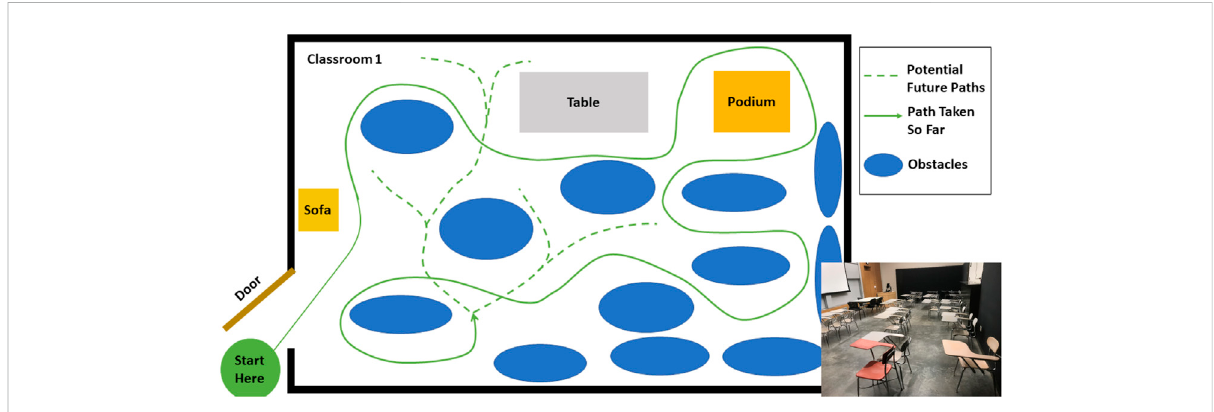
FIGURE 2 Classroom: Architecture of one of the classrooms. The arrangement of obstacles was not controlled and varies across subjects. The subject walked at self-selected speed and along self-selected path, The experimenter directed the subject to change their path only if the subject repeated the same path more than 2 times.